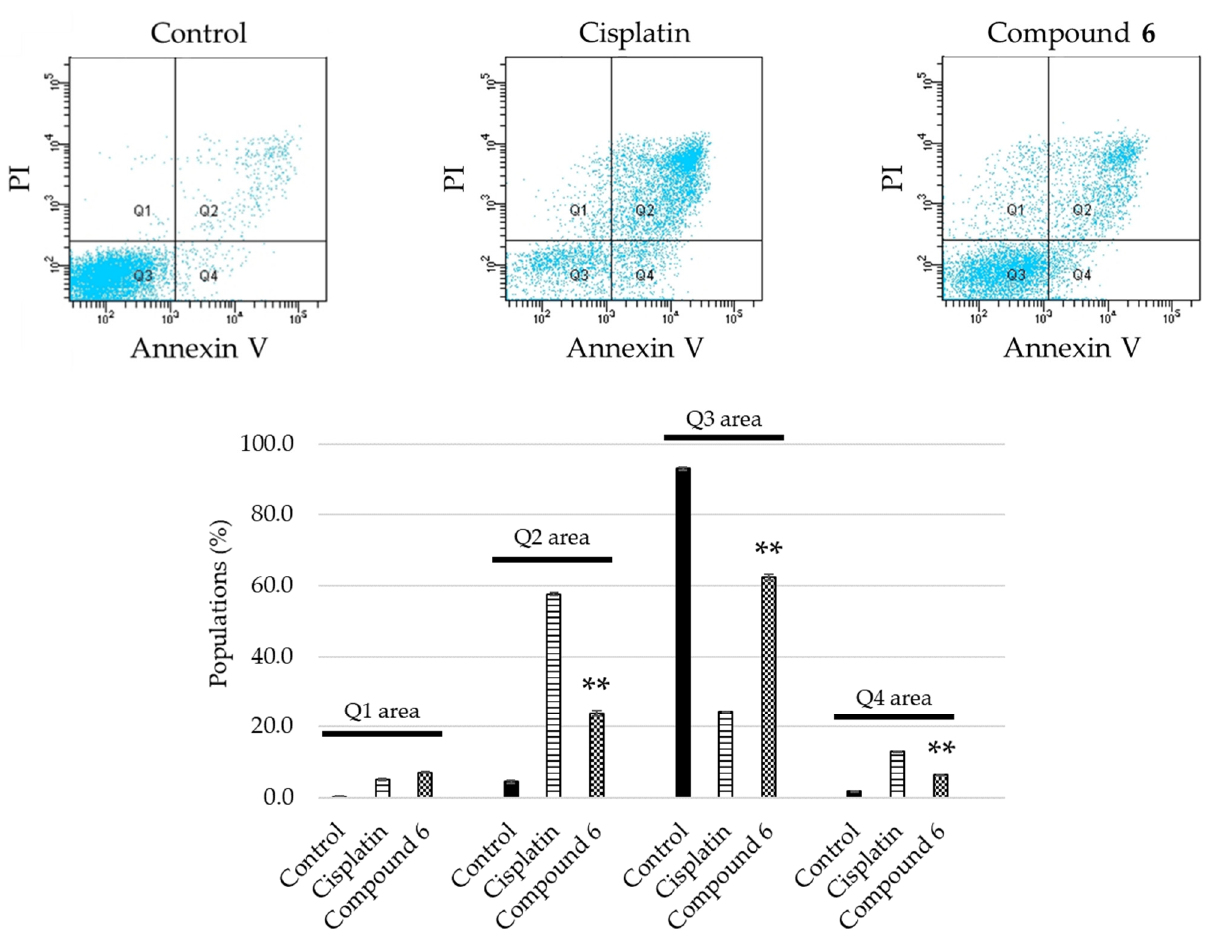
Figure 5. Detection of apoptosis in HL-60 cells treated with cisplatin or 6 . Top: HL-60 cells were treated with either 20 μ M of cisplatin or 40 μ M of 6 for 24 h, and then stained with Annexin V and propidium iodide (PI), followed by flow cytometry analysis. Bottom: the percentage of dead cells (Q1 area), late apoptotic cells (Q2 area), live cells (Q3 area), and early apoptotic cells (Q4 area) in the cell population are shown as mean ± S.E.M. of three experiments (** p < 0.001 vs. control group).